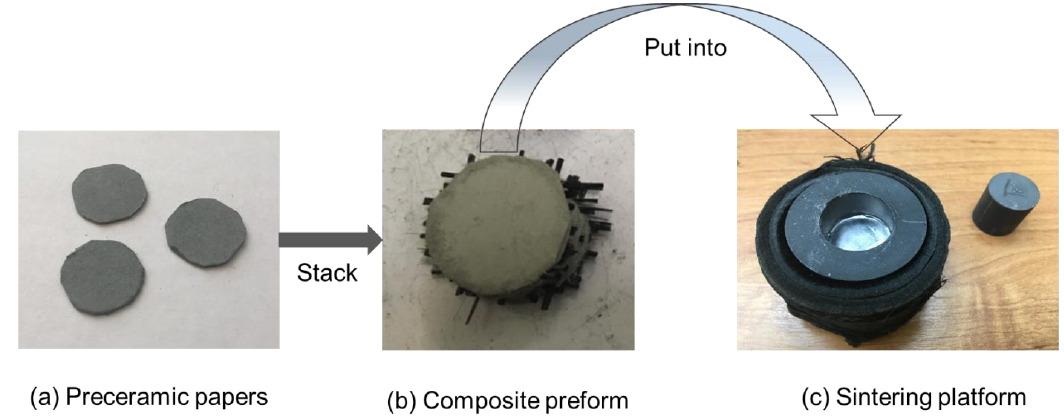
Figure 1. Preparation of preforms for spark plasma sintering: ( a ) cut preceramic paper; ( b ) stacked preceramic paper sheets with fiber layers; ( c ) sintering platform.